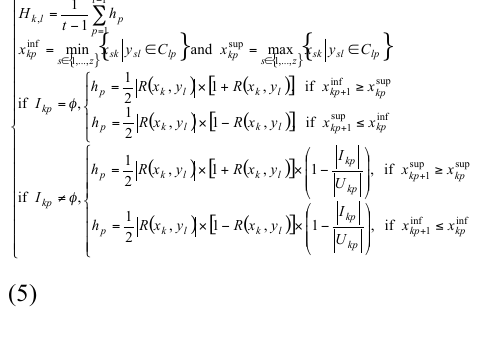
Fig. 3. Relationship between the input and output